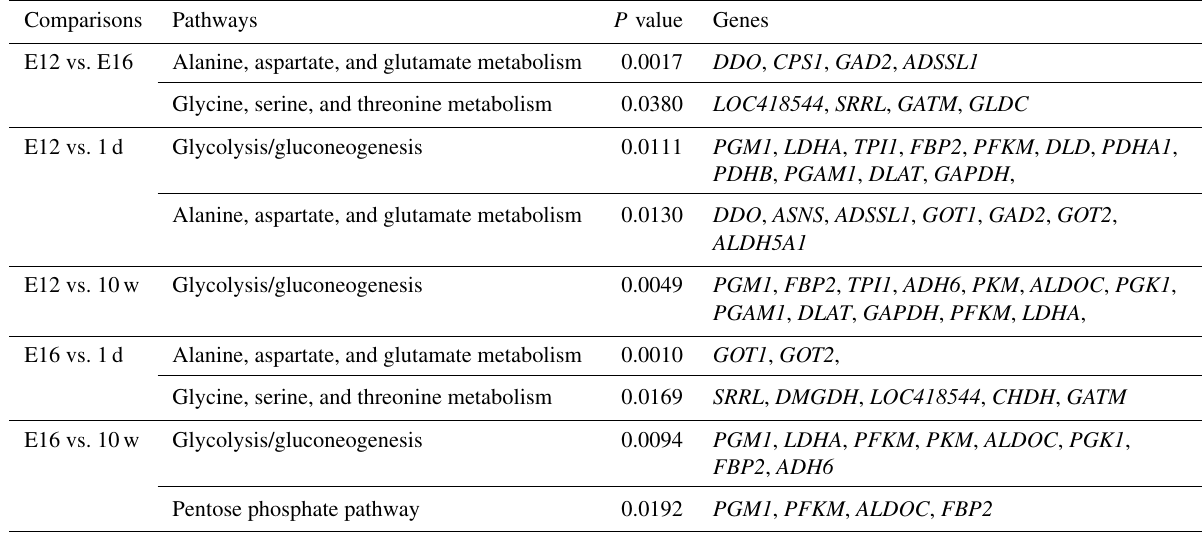
Table 4. Pathways related to the metabolism of amino acids, carbohydrates, and lipids. Comparisons